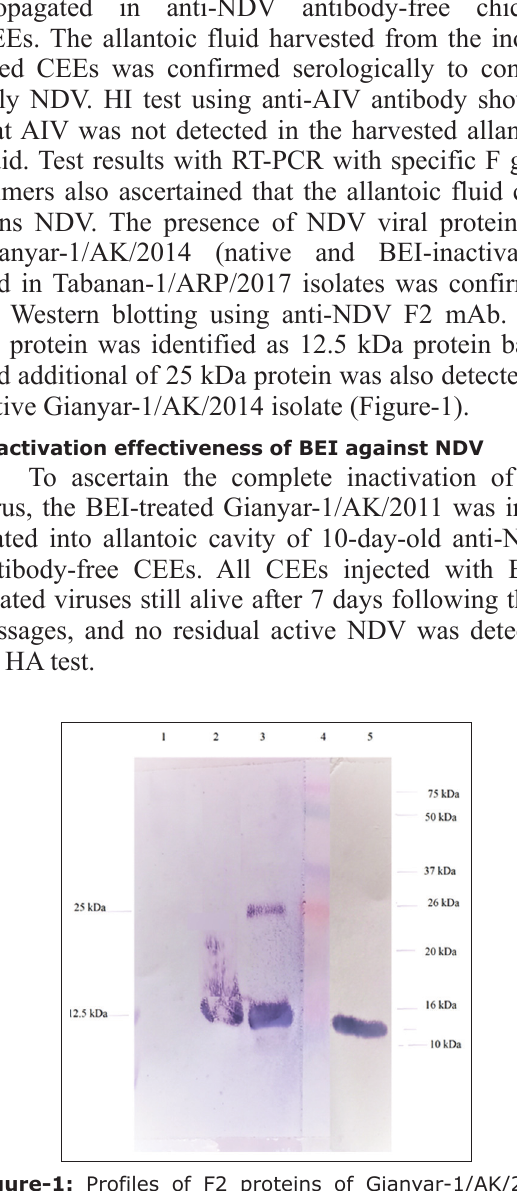
Figure-1: Profiles of F2 proteins of Gianyar-1/AK/2014 (native and binary ethylenimine [BEI]-inactivated) and Tabanan-1/ARP/2017 isolates analyzed by Western blotting using anti-Newcastle disease virus F2 mAb. (Line 1, 2, 3, and 5): Normal allantoic fluid, BEI-inactivated Gianyar-1/ AK/2014), active Gianyar-1/AK/2014, and Tabanan-1/ ARP/2017, respectively. Line 4: prestained protein standard